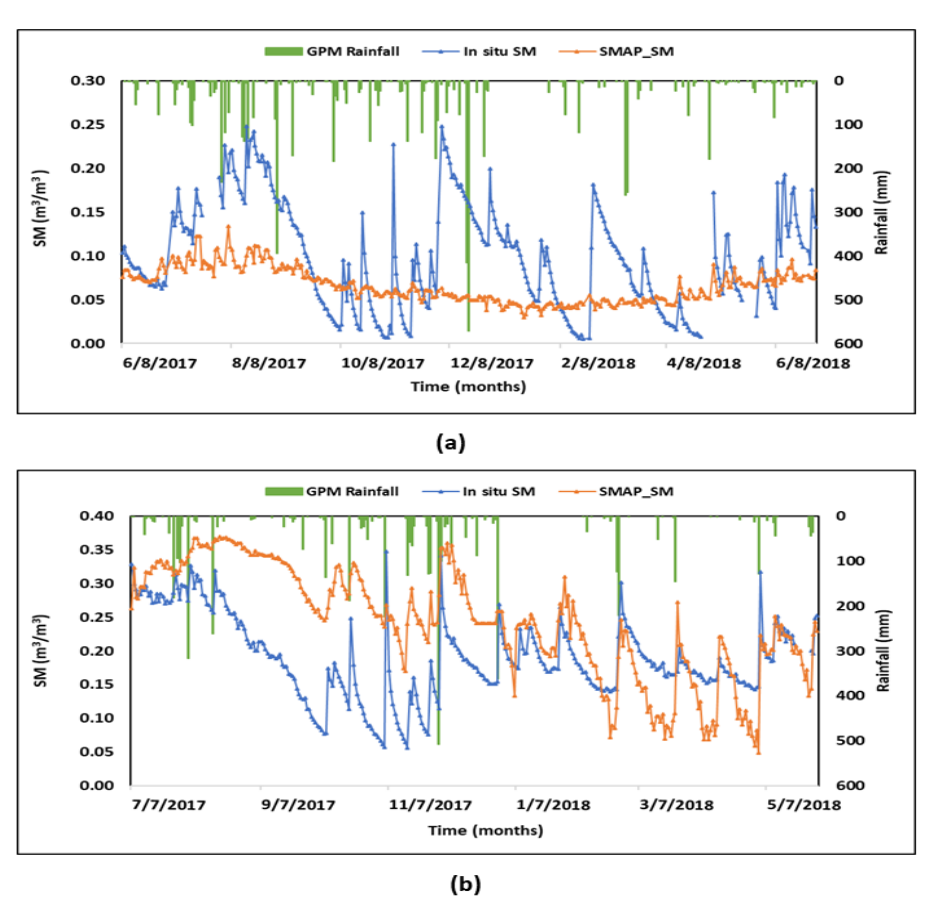
Figure 10. Temporal series plot between the SMAP SM, in situ SM and GPM rainfall for ( a ) Cox and ( b ) Samarra, Australia.